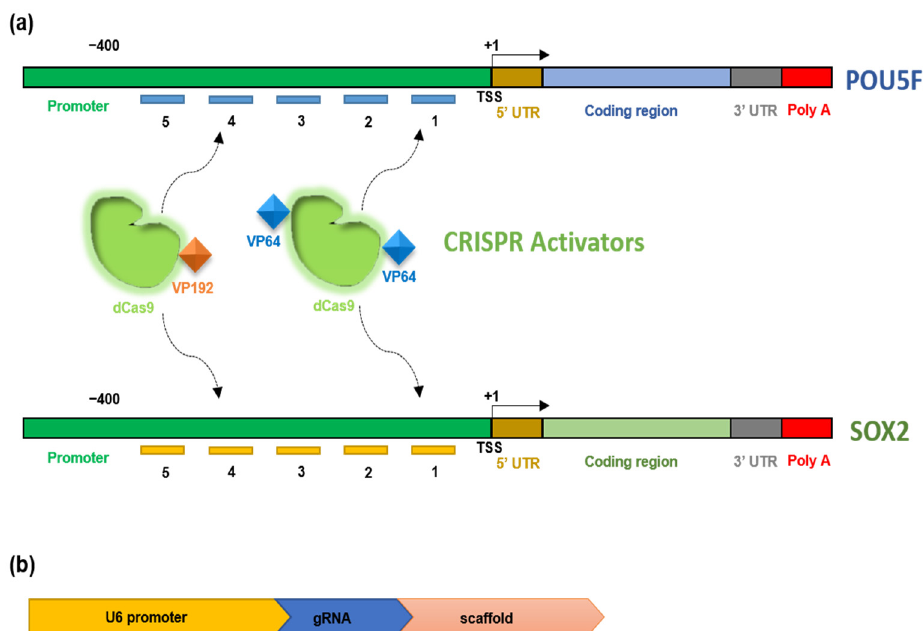
Figure 1. Construction of multiplex plasmid targeting POU5F1 and SOX2 ( a ) Graphical depiction of the promoter region of POU5F1 and SOX2 genes, where number 1–5 represents the particular gRNA. ( b ) The expression cassette in each array plasmid constitutes U6 promoter, cloned gRNA, and scaffold. TSS, transcription start site. UTR, untranslated region. dCas9, deactivated CRISPR-associated protein 9. VP, virus protein. gRNA, guide RNA.